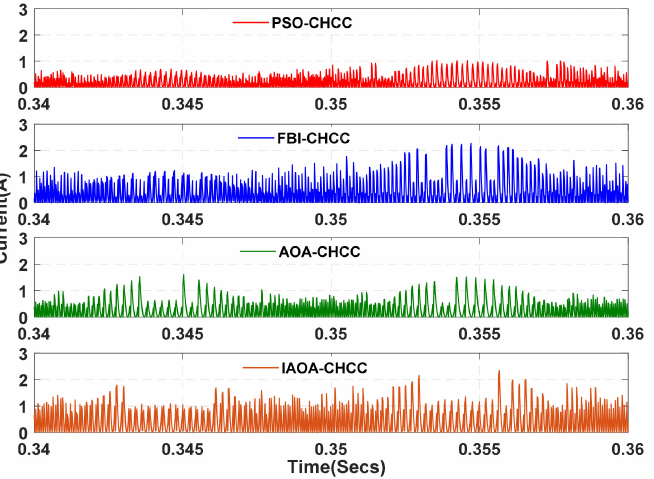
Figure 17. Simulation results showing current error for PSO-CHCC, FBI-CHCC, AOA-CHCC, and